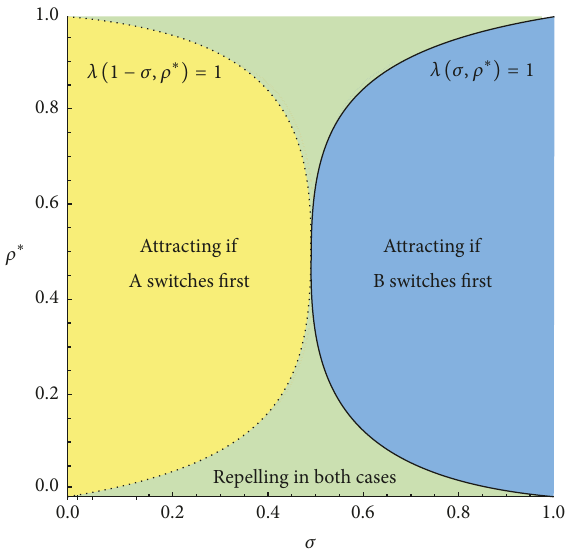
Figure 6: Bifurcation diagram for the stability of the single group solution to splitting in two. Stable if the parameters lie in the yellow or blue regions (the groups will ultimately merge); unstable in the green parameter region (the groups will never merge). Boundary lines are solutions to (61) as a function of 𝜎 (or 1 − 𝜎 to capture switching order reversal) and 𝜌 ∗